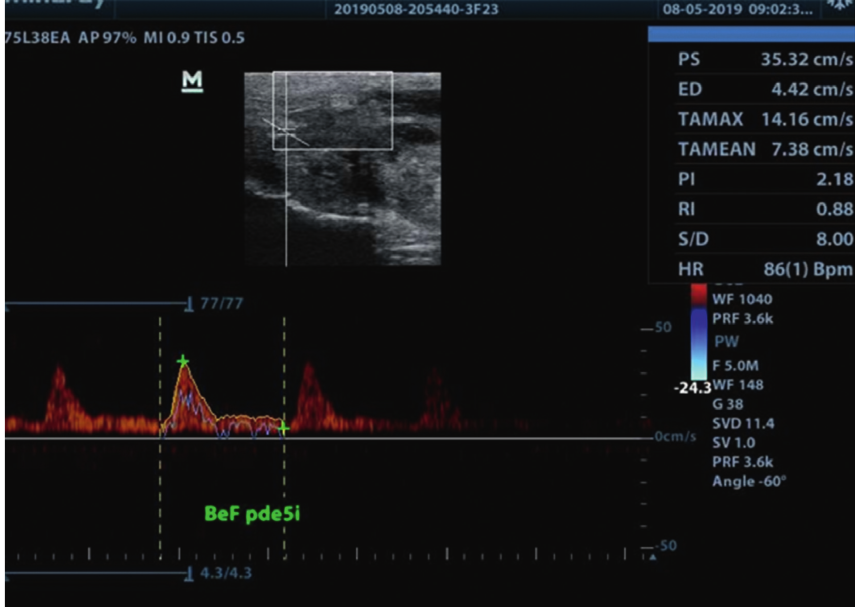
Figure 2: Postoperative baseline hemodynamics. PDDU showing postoperative baseline hemodynamics before administration of PDE5i. Note that Figures 2 and 3 are for the same